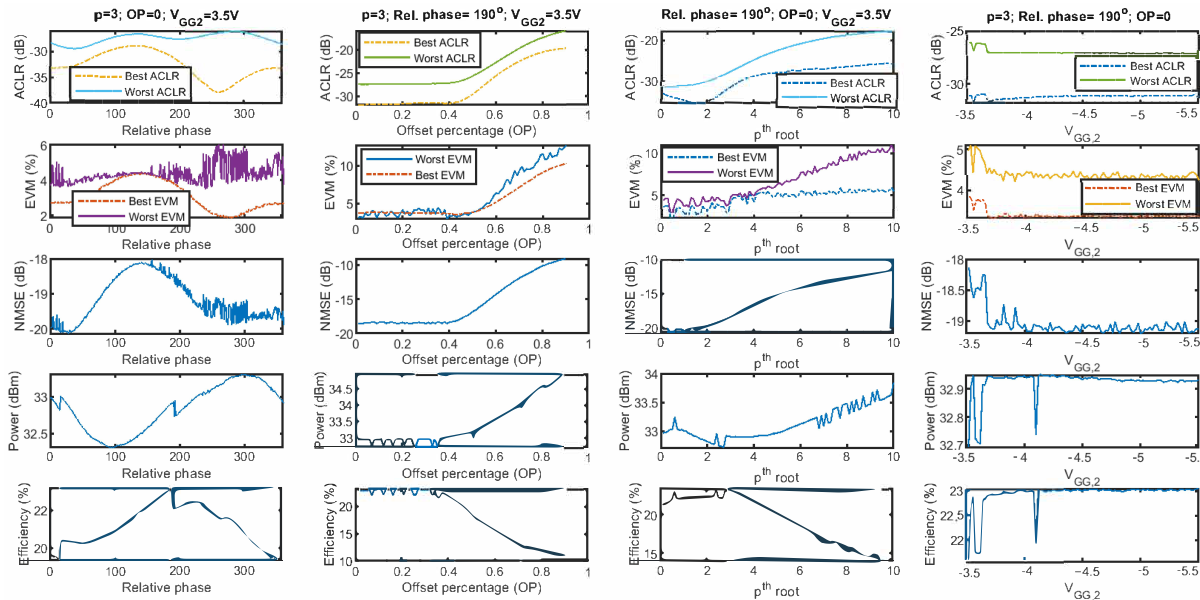
Figure 8. Evaluation of the FOMs, namely: best and worst case, EVM (best and worst case (ACLR)), NMSE, mean output power, mean power efficiency; when sweeping the values of the following degrees of freedom individually: relative phase ( ψ rel ), offset percentage ( OP ), degree of the root ( p ), and the gate voltage of the CSP amplifier ( V GG ,2